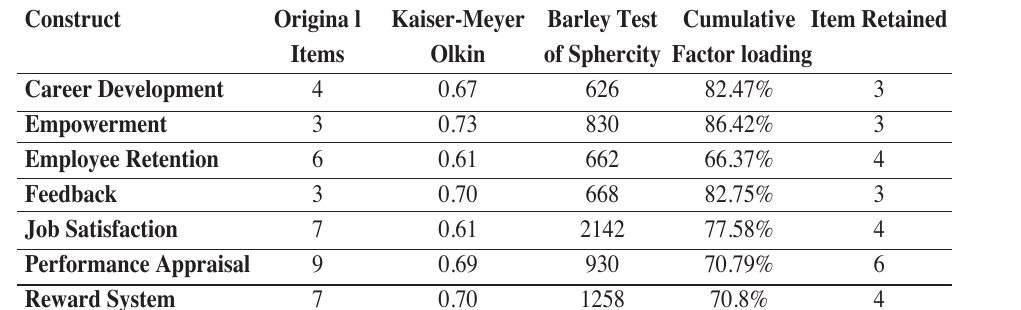
Table 3: EFA result after dropping items Construct